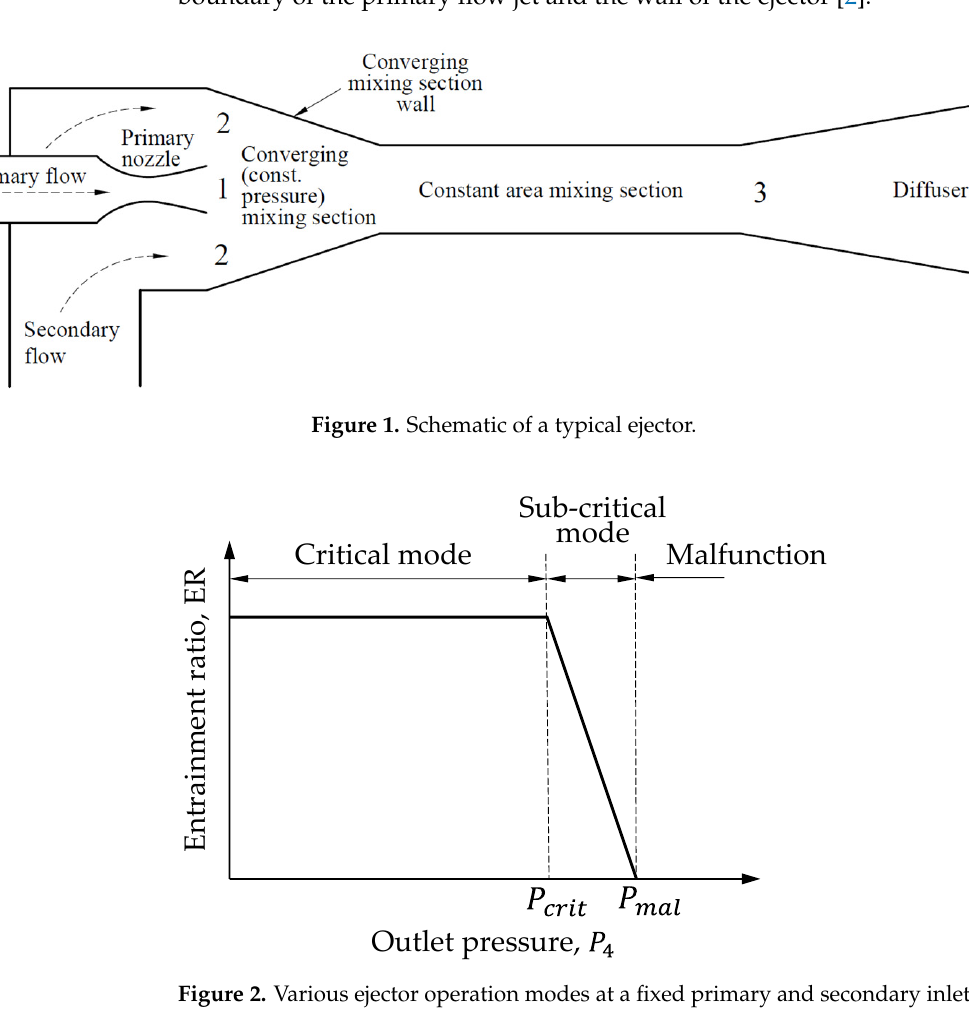
Figure 1. Schematic of a typical ejector.